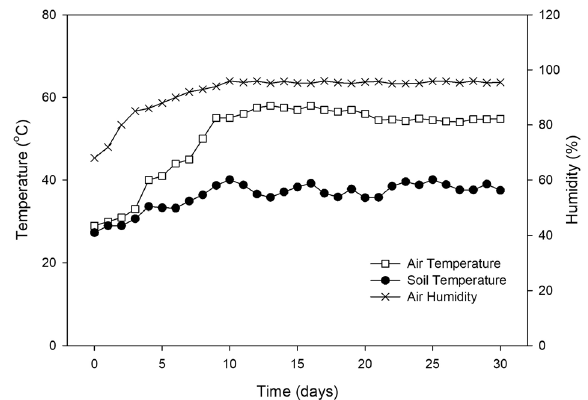
Figure 1. The temperature (soil and air) and relative humidity (air) in the greenhouse during the BSD treatment.